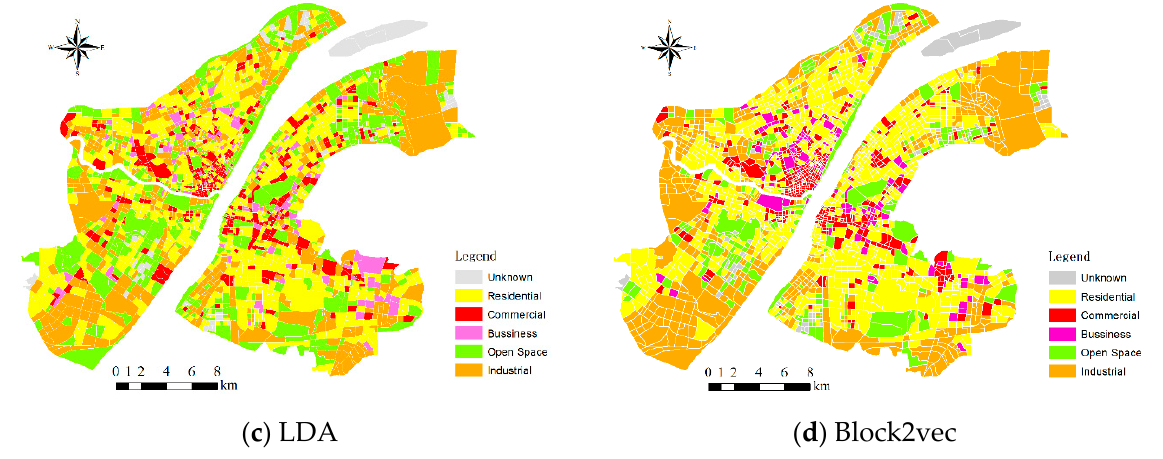
Figure 9. Urban functional region classification results via different methods.